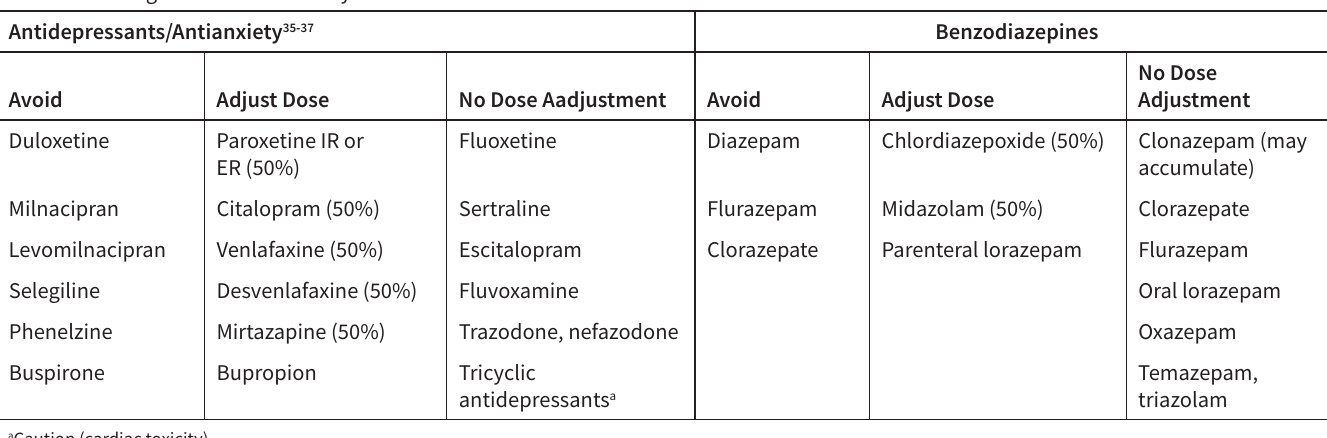
Table 2. Management of Antianxiety Medications in ESKD Patients